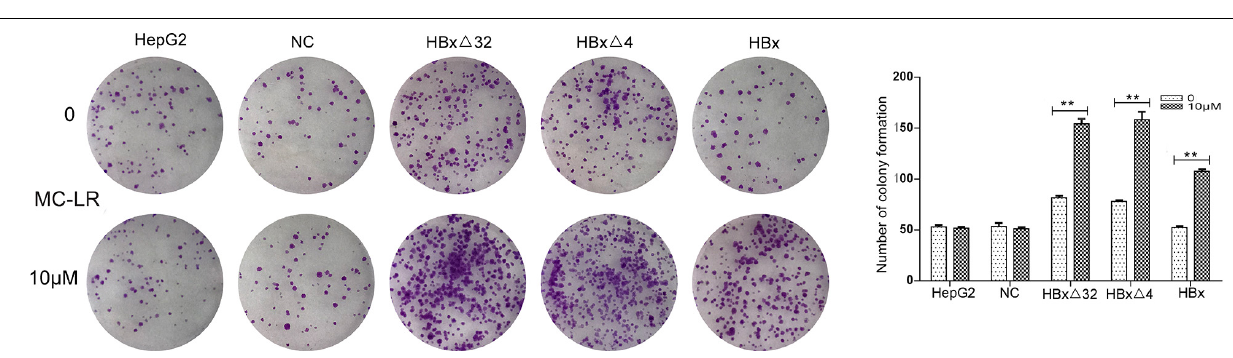
the MC-LR exposure time. These results confirm that MC-LR and HBx (cid:49) 32 synergistically activate the MAPK signaling